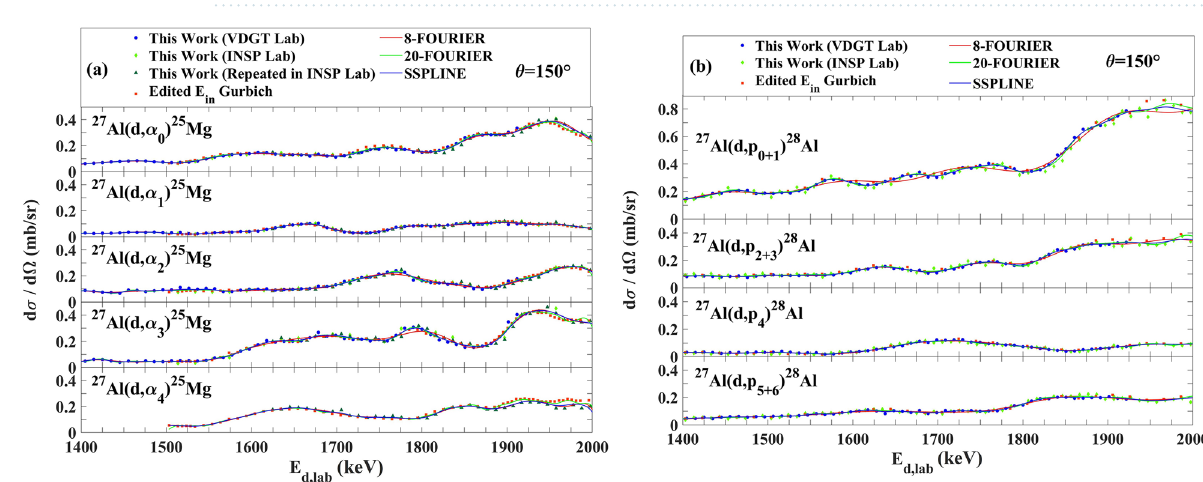
Figure 11. The comparison of our work with other data at 150° for ( a ) 27 Al(d,α 0,1,2,3,4 ) 25 Mg and ( b ) 27 Al(d,p 0+ 28 Al reactions 14,25 . 1,2+3,4,5+6 )